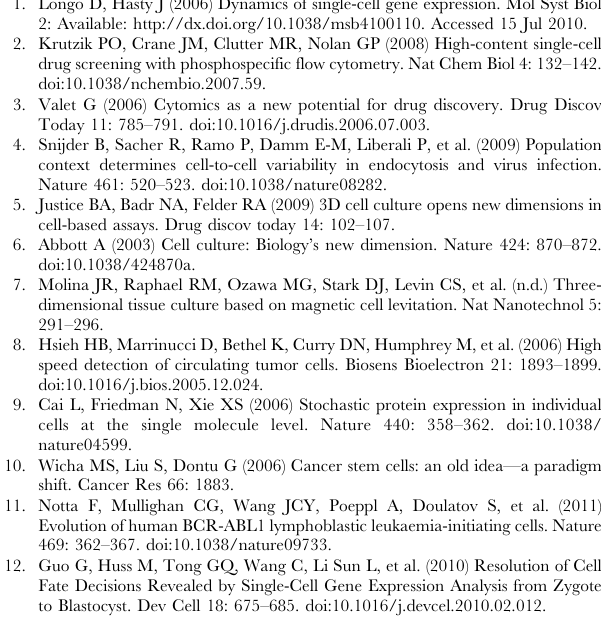
Figure S1 Frequency response of a fixated cell. (error bars are inside the dots, values represent mean + / 2 0.5*s.d. , n= 18). (TIF) Figure S2 Changes in the rotation period of a single HeLa cell. In DMEM (blue circles) compared to a fixated HeLa cell (red squares) in DMEM. Figure S3 Clonogenic assay on HeLa cells. HeLa cells incubated with magnetic nanoparticles (12.5 ug/ml, unfiltered) and rotated for 24 hrs in an incubator. For each sample, after incubation with magnetic nanoparticles following the standard protocol, cells were washed, detached and counted. 10000 cells were then rotated for 24 hrs at 37 u C, in a 5% CO2 environment with humidity control. Using a 6-well plate, 200 cells were put to grow on an agarose layer (1.3% agarose in DMEM) for 3 weeks. Control cells were not exposed to nanoparticles nor to any magnetic field. Control cells were washed, detached, counted and